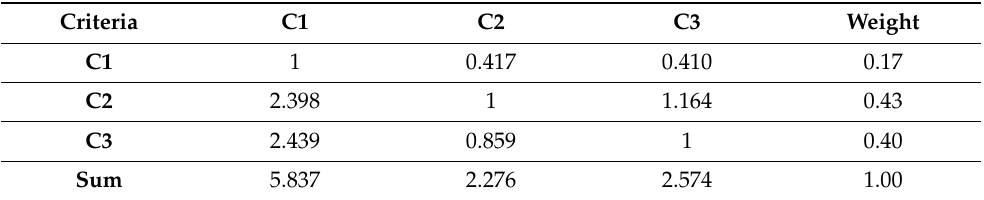
Table 10. Pairwise comparison matrix for industrial land use suitability using the geometric mean of the preferences with the computed